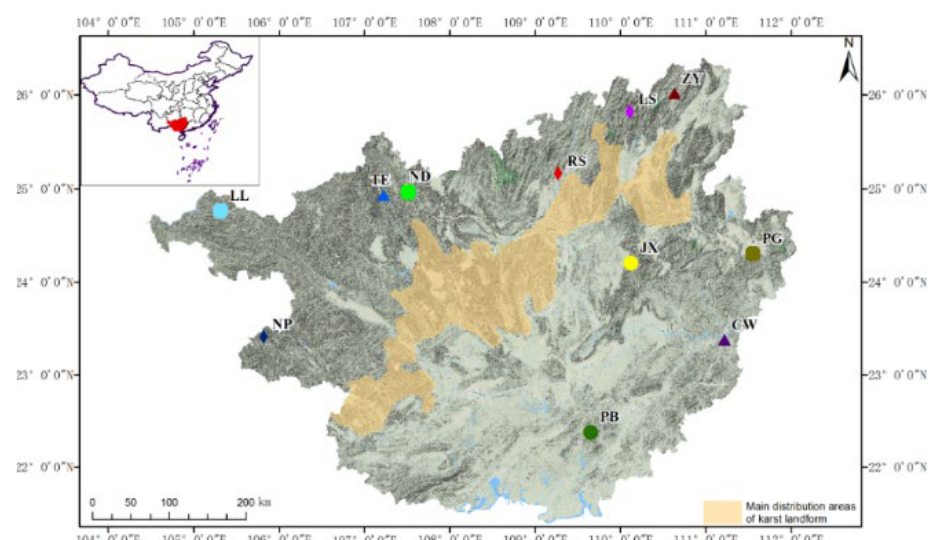
Figure 1. ( A ) Twigs and cones of Chinese fir. ( B ) Trunks and tree canopies of Chinese fir.